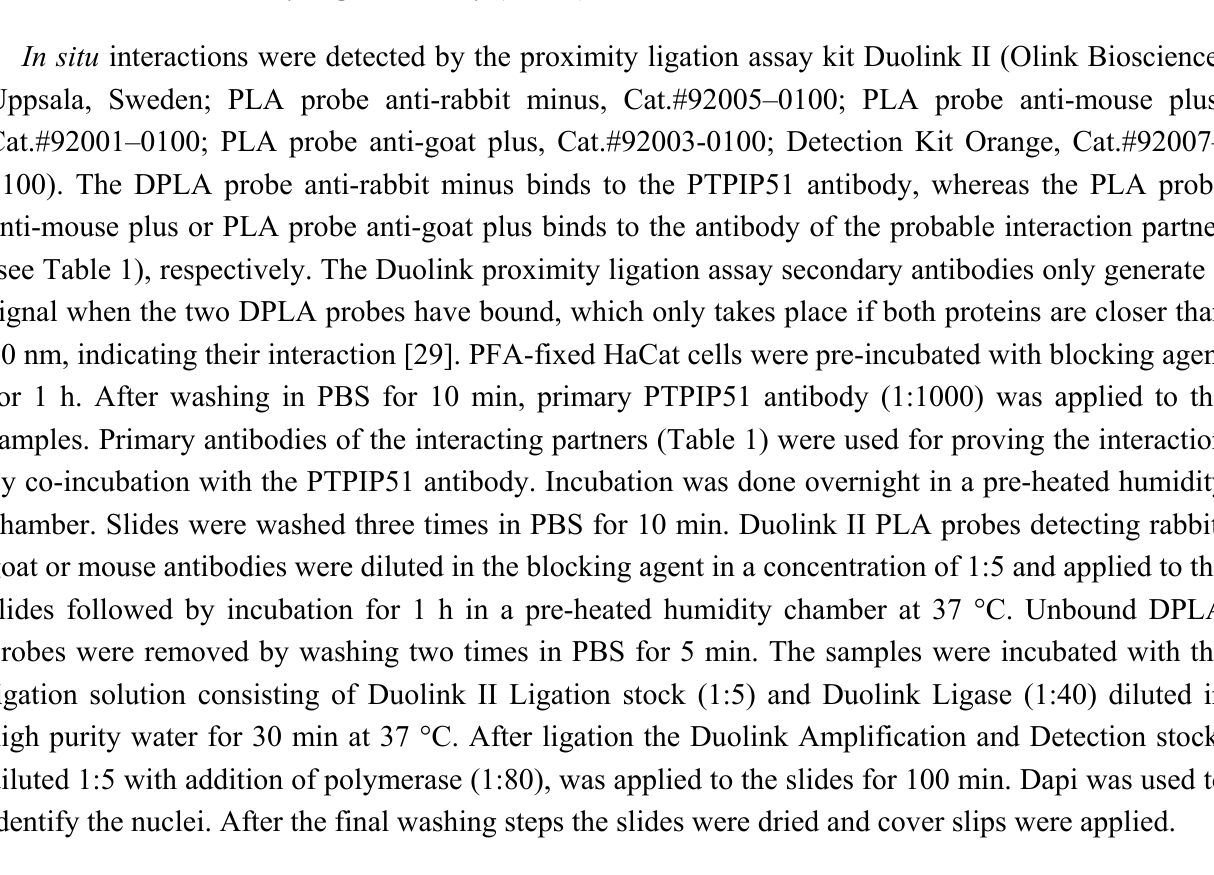
Table 1. List of antibodies used in this